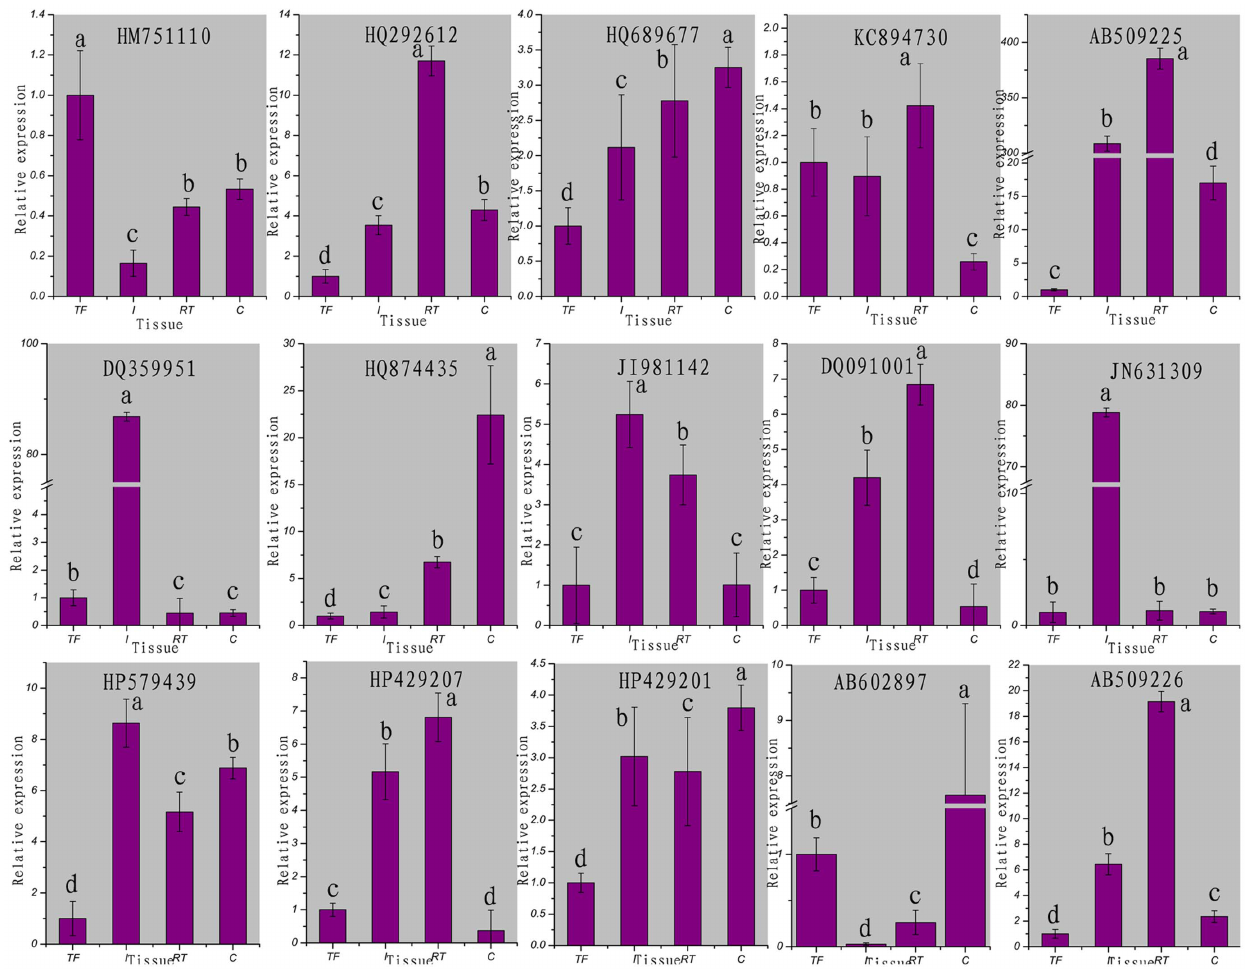
Figure 7. Quantitative realtime PCR analysis of the expression of 15 selected predicted target genes in different tissues of sea cucumber. The tissues are abbreviated as follows: TF, tube foot; I, intestine; RT, respiratory tree, and C, coelomocytes. Bars are shown as mean 6 standard deviation. Bars with different superscripts indicate that they are significantly different from each other ( p , 0.05).